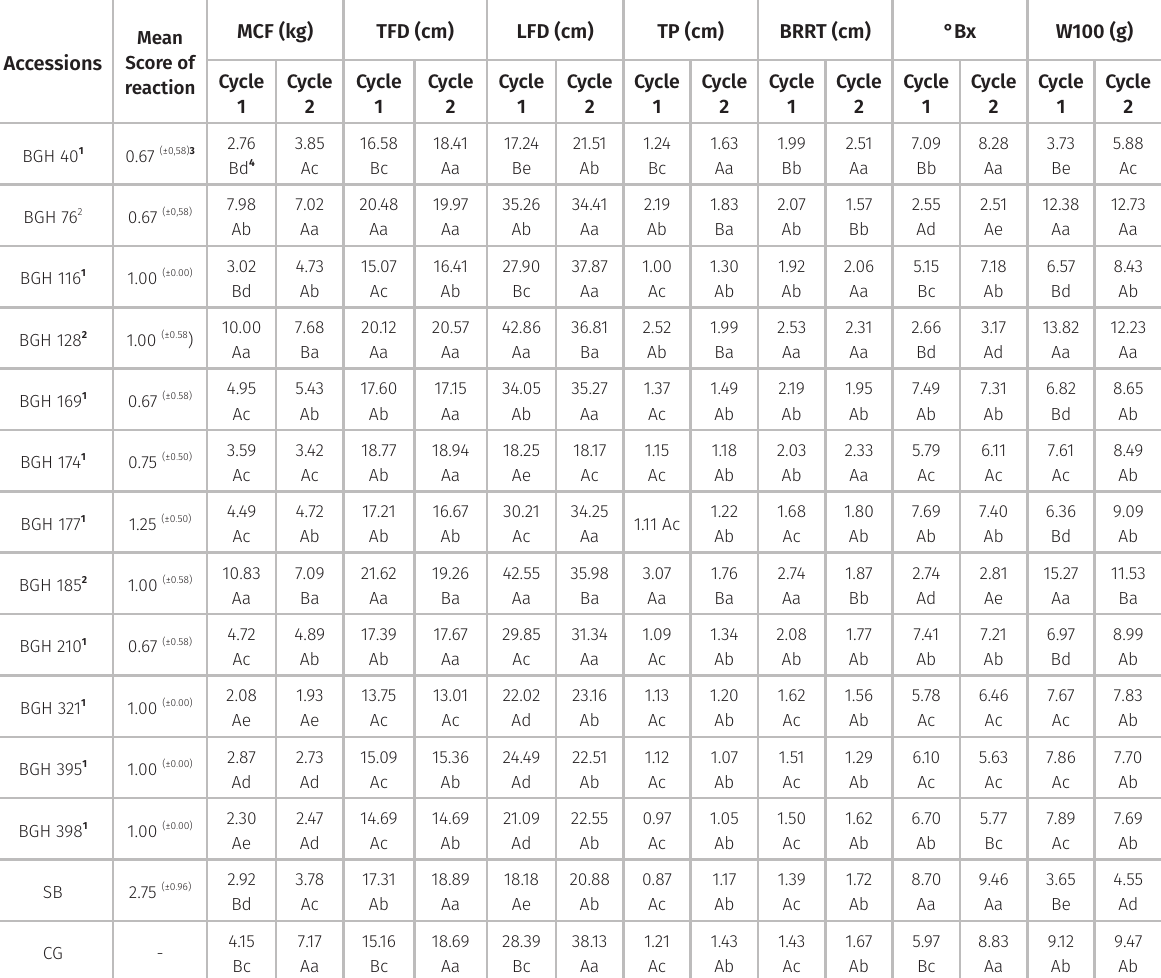
Table II. Mean score of reaction of the accessions of watermelon plus the Sugar Baby cultivar inoculated with Fusarium oxysporum f. sp niveum ( Fon ). Averages of the 12 accessions plus the cultivars Sugar Baby (SB) and Charleston Gray (CG) for the variables that presented significant value for the genotype-environment interaction: mass of characterized fruit (MCF), transverse fruit diameter (TFD) and longitudinal fruit diameter (LFD), thickness pericarp (TP) and basal region rind thickness (BRRT), soluble solids (°Bx), weight of 100 seeds (W100) and branch length